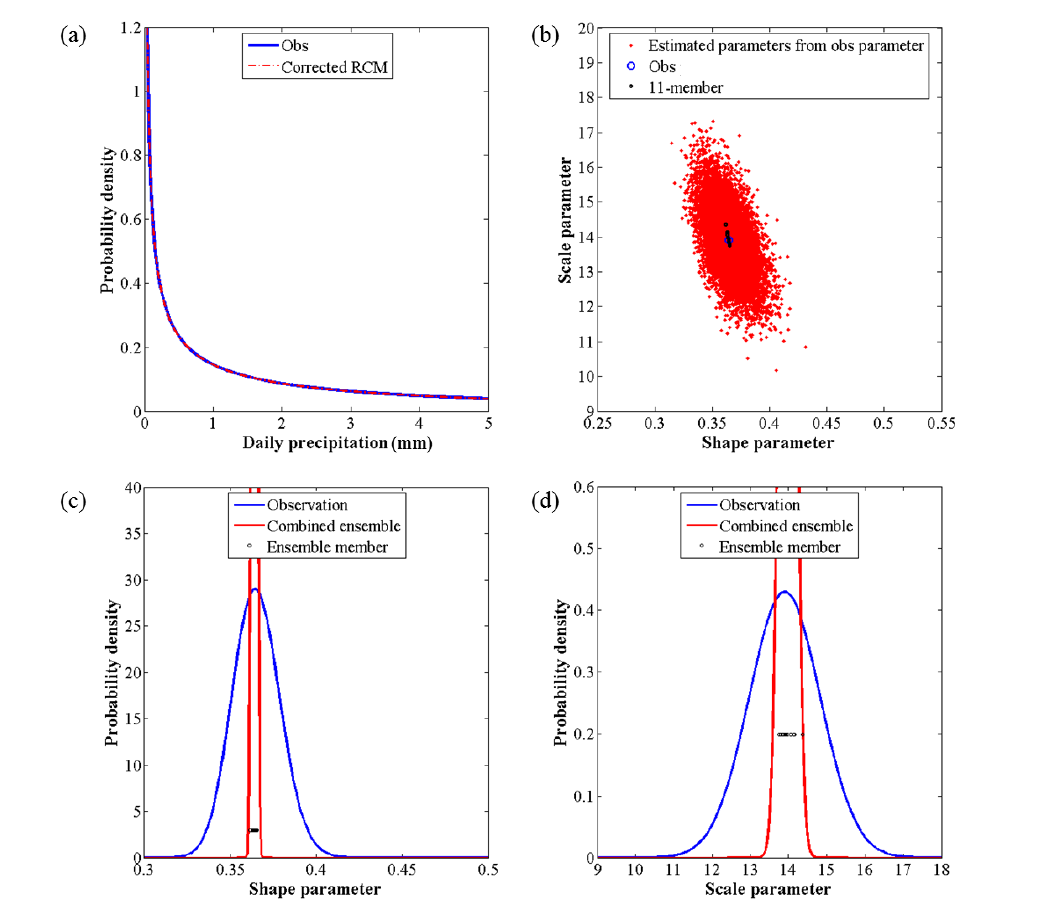
Figure 9. Results of the conventional bias correction method: (a) probability density functions of the observed and simulated (i.e. 11-member) precipitation after bias correction; (b) scatter plot between shape and scale parameters of the observed and bias corrected precipitation; (c–d) probability density functions of the shape and scale parameters of the observed and bias corrected